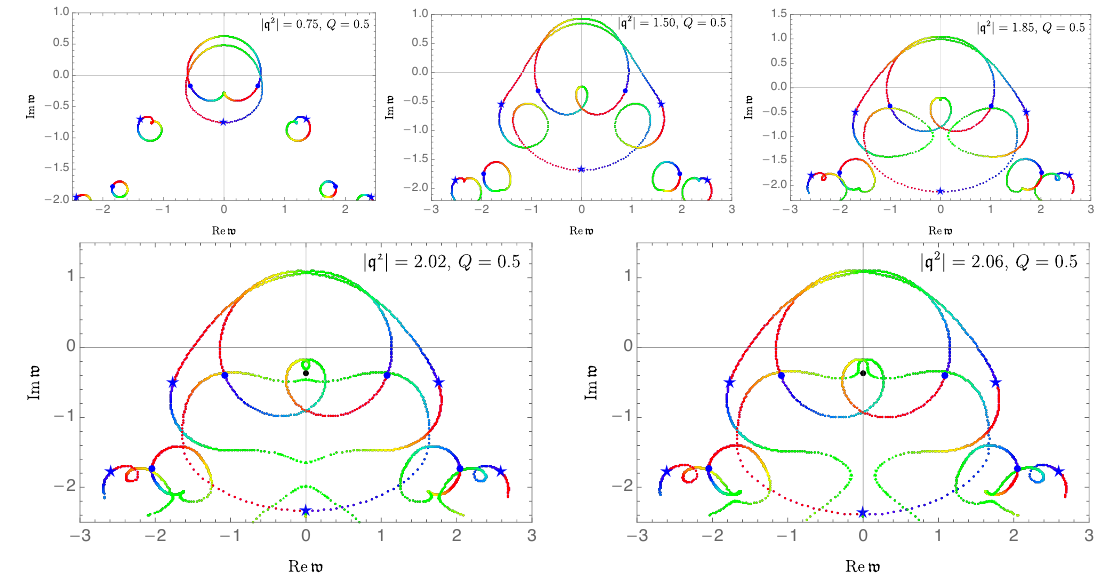
Figure 9. Poles of the retarded two-point function in the spin 0 channel at Q = 0 : 5, in the complex w (cid:0) plane, at various values of the complexi(cid:12)ed momentum q 2 = j q 2 j e i(cid:18) . Large dots and large stars correspond to the poles with purely real momentum (i.e. at (cid:18) = 0). As (cid:18) increases from 0 to 2 (cid:25) , each pole moves counter-clockwise following the trajectory whose color changes continuously from blue to red. While at j q 2 j = 0 : 75 (top left panel) all poles follow closed orbits, at j q 2 j = 1 : 50 (top middle panel), the hydrodynamic di(cid:11)usion pole and the two lowest star gapped poles follow open orbits. It simply means that the dispersion relation of w di(cid:11)usion ( q ) has branch point singularities in the complex momentum squared plane at (0 : 75) 1 = 2 < j q c j < (1 : 50) 1 = 2 . It is clear that the point ( Q = 0 : 5 ; j q c j ) lies on the red curve in (cid:12)gure 7. At j q 2 j = 1 : 85 (top right panel) the orbits of the hydrodynamic sound pole and the two nearest dot poles are still closed. But interestingly, the trajectory of the di(cid:11)usion pole seems going to become closed again. At j q 2 j = 2 : 02 (bottom left panel), the orbit of di(cid:11)usion pole is already closed, however it nearly collide the left sound pole at a position marked by black dot on the vertical axis. The collision point is identi(cid:12)ed with critical value of momentum j q 2 j = 2 : 04. As expected, the point ( Q = 0 : 5 ; j q c j = (2 : 04) 1 = 2 ) lies on the blue c curve in (cid:12)gure 7. After the collision, for instance at j q 2 j = 2 : 06, the orbits of sound poles and the di(cid:11)usion pole are no longer closed. They exchange their positions cyclically as the phase increases from 0 to 2 (cid:25) . This is the manifestation of the (cid:22) T (cid:22) J (cid:0) crossing